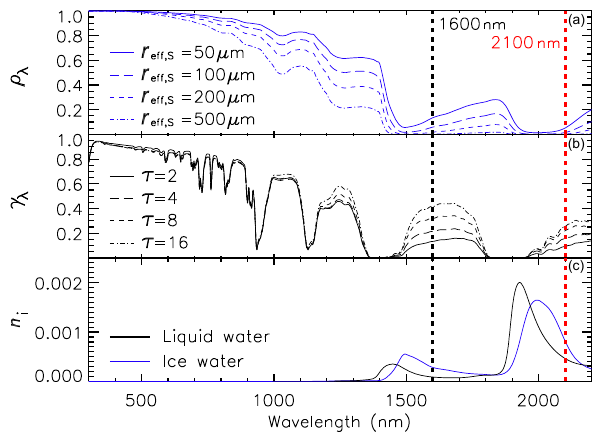
Figure 1. Comparison of spectral snow albedo ρ λ (a) and cloud re- flectivity γ λ (b) for different r eff , S and τ , respectively. Cloud re- flectivity has been simulated for clouds with r eff , C = 10µm that are located above a snow surface with r eff , S = 100µm. The imagi- nary part of the refractive index of ice and liquid water is given in panel (c) . Vertical lines indicate the wavelength used in the bispec- tral cloud